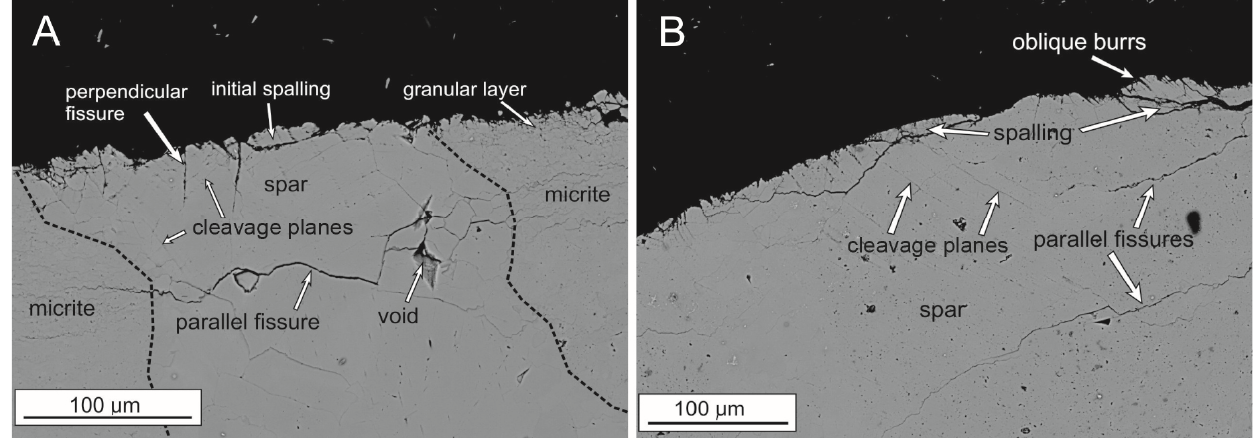
Figure 11. Weathering rind at site 1 (subject to weathering for 1–2 years). ( A )—spar vein cutting micritic limestone; ( B )—weathering rind developed on the spar (images from FE-SEM).